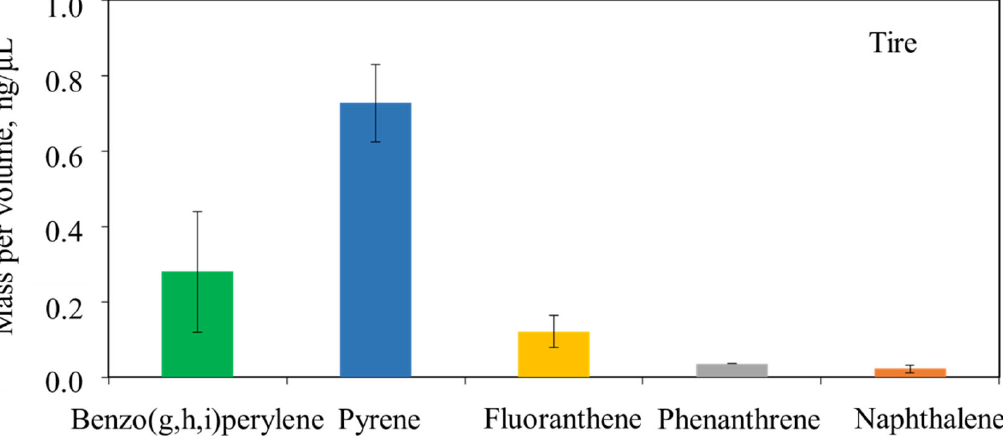
Figure 6. The distribution of benzo(g,h,i)perylene, pyrene, fluoranthene, phenanthrene, and naphthalene of PAHs in the tire samples. Error bars indicate 95% confidence intervals.